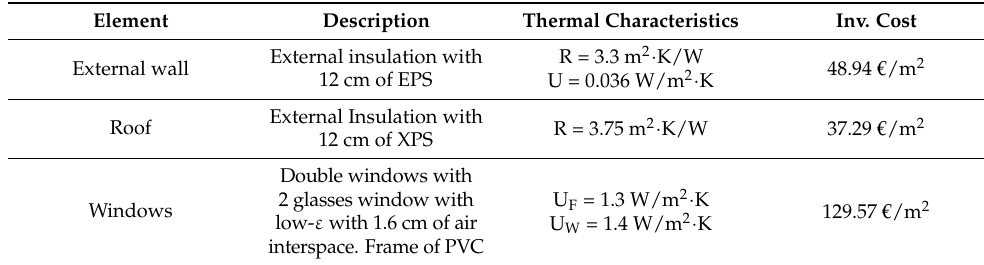
Table A10. POS12: Renovation measures of solution